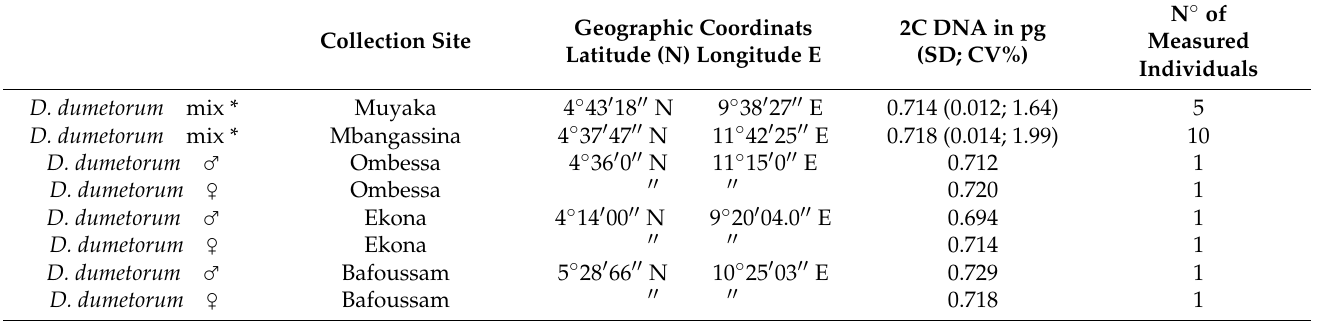
Table 1. Origin of material and 2C DNA values obtained for Dioscorea studied accessions. Geographic Coordinats Collection Site Latitude (N) Longitude E